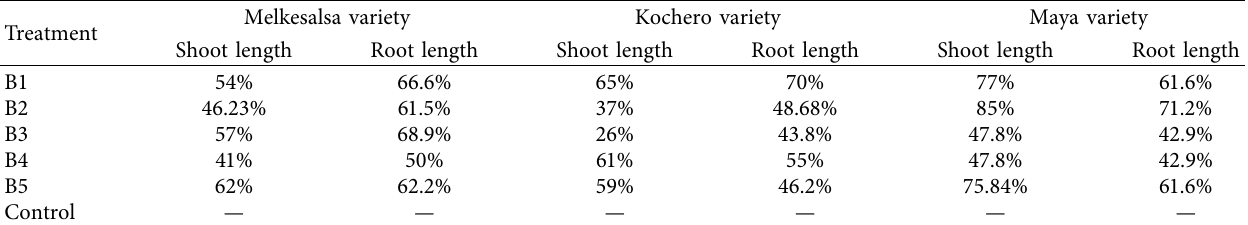
Table 6: Efficacy of Bacillus on the growth promotion of tomato seedlings.